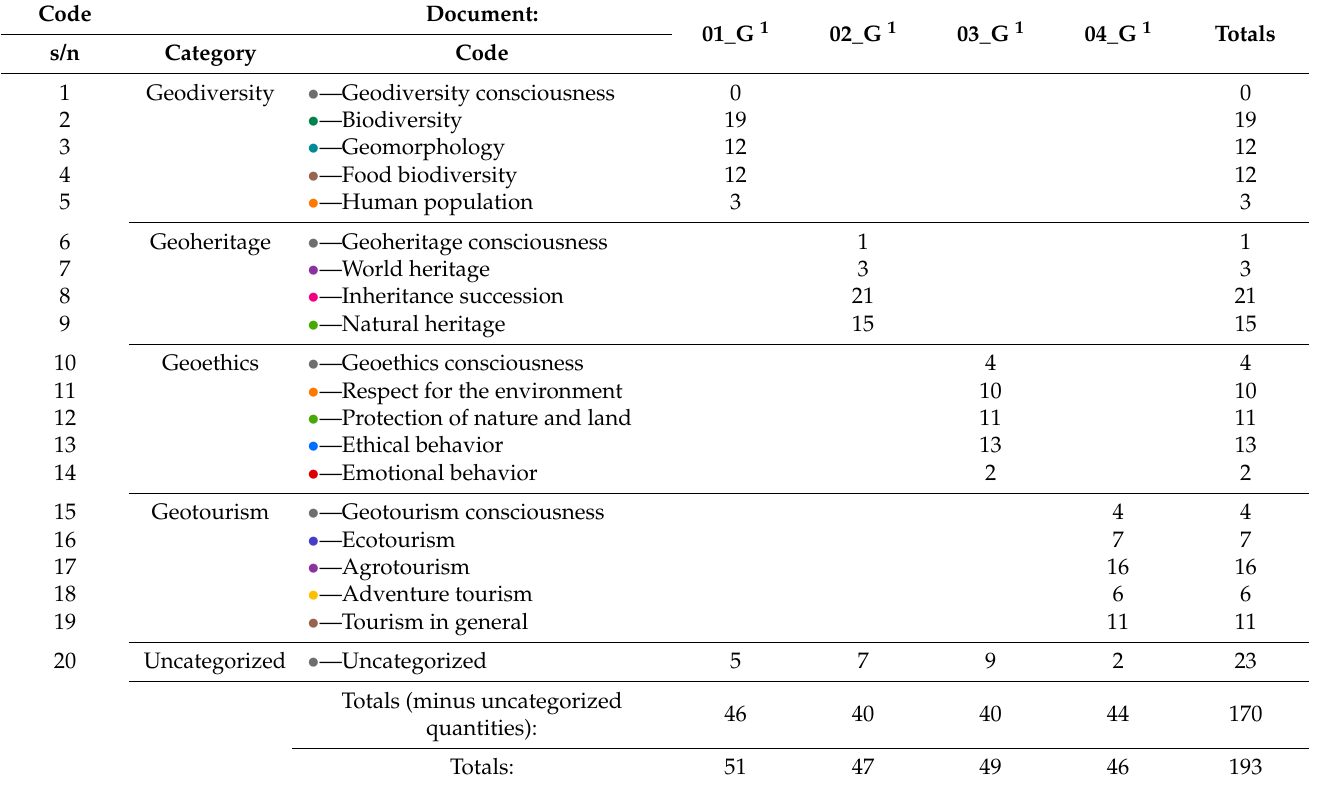
Table 1. Semiotics content analysis/thematic analysis: number of conceptual patterns per docu- ment/category and code. Coding color